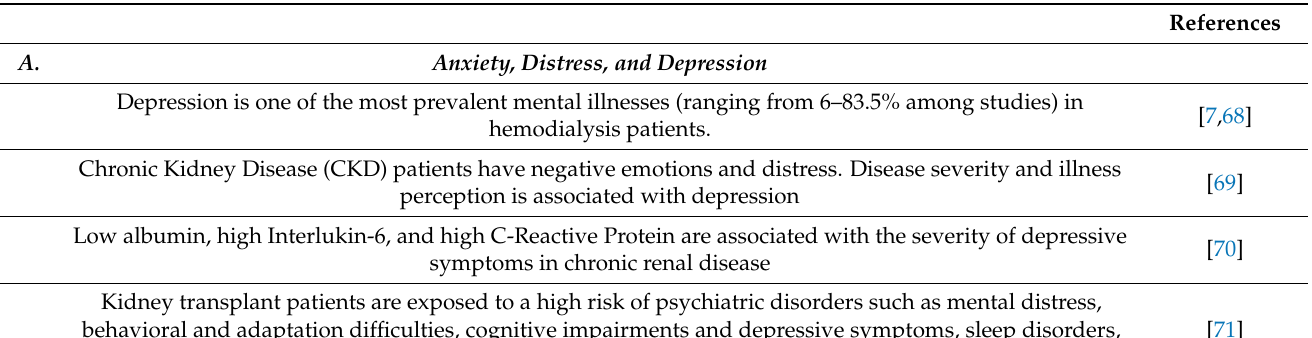
Table 3. Psychological backgrounds of patients with renal